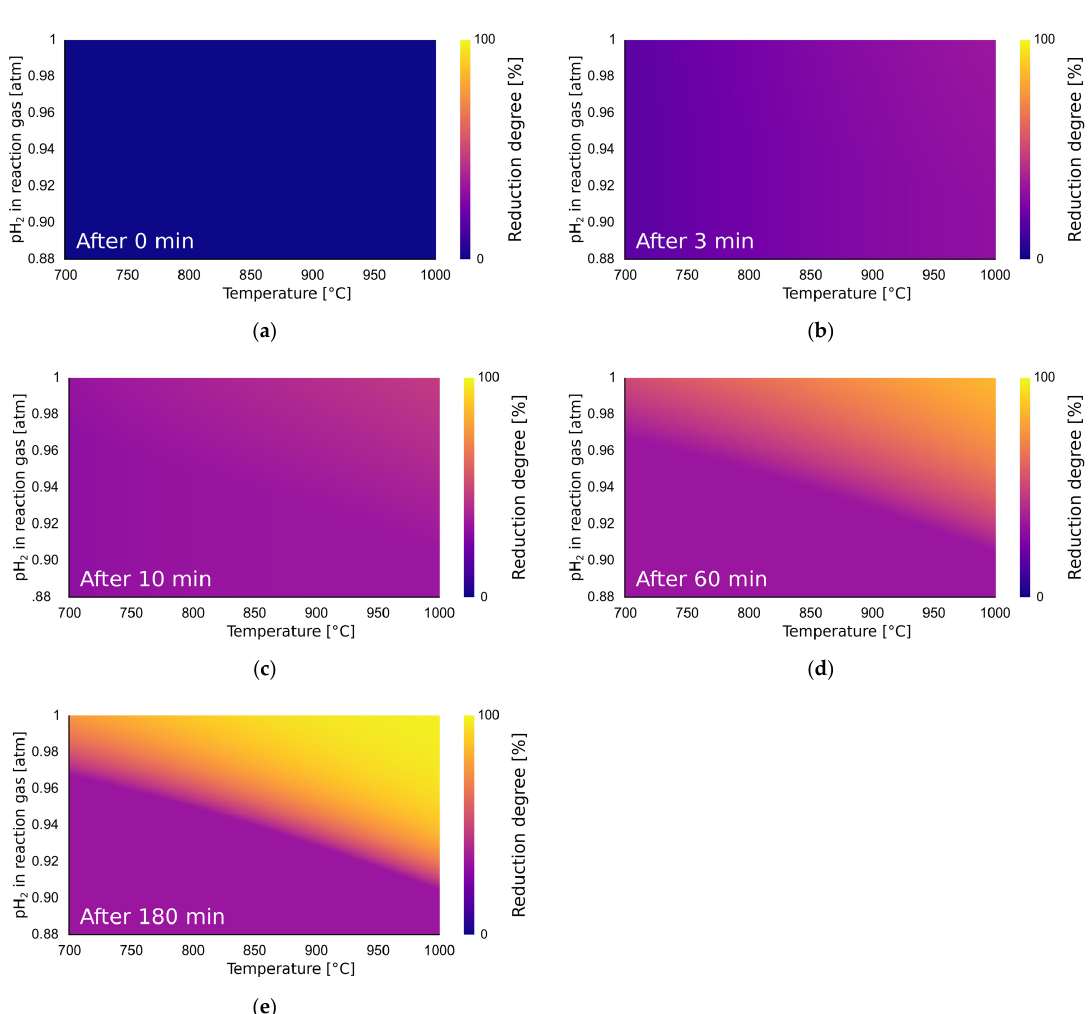
Figure 12. Reduction degree heatmap for temperatures between 973 and 1273 K (700–1000 °C) and hydrogen partial pressure between 0.88 and 1 atm. Images correspond to ( a ) 0 min of reaction; ( b ) 3 min of reaction; ( c ) 10 min of reaction; ( d ) 60 min of reaction; ( e ) 180 min of reaction.